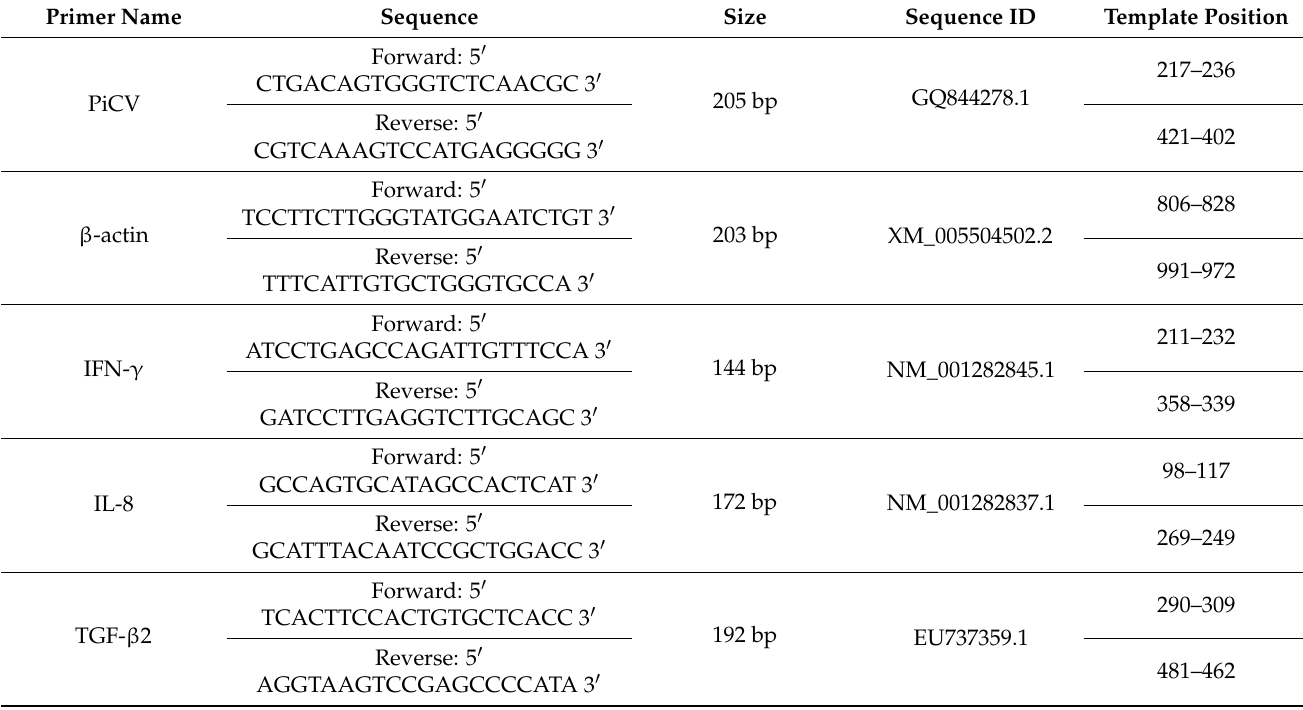
Table 1. Primers used for quantitative real-time